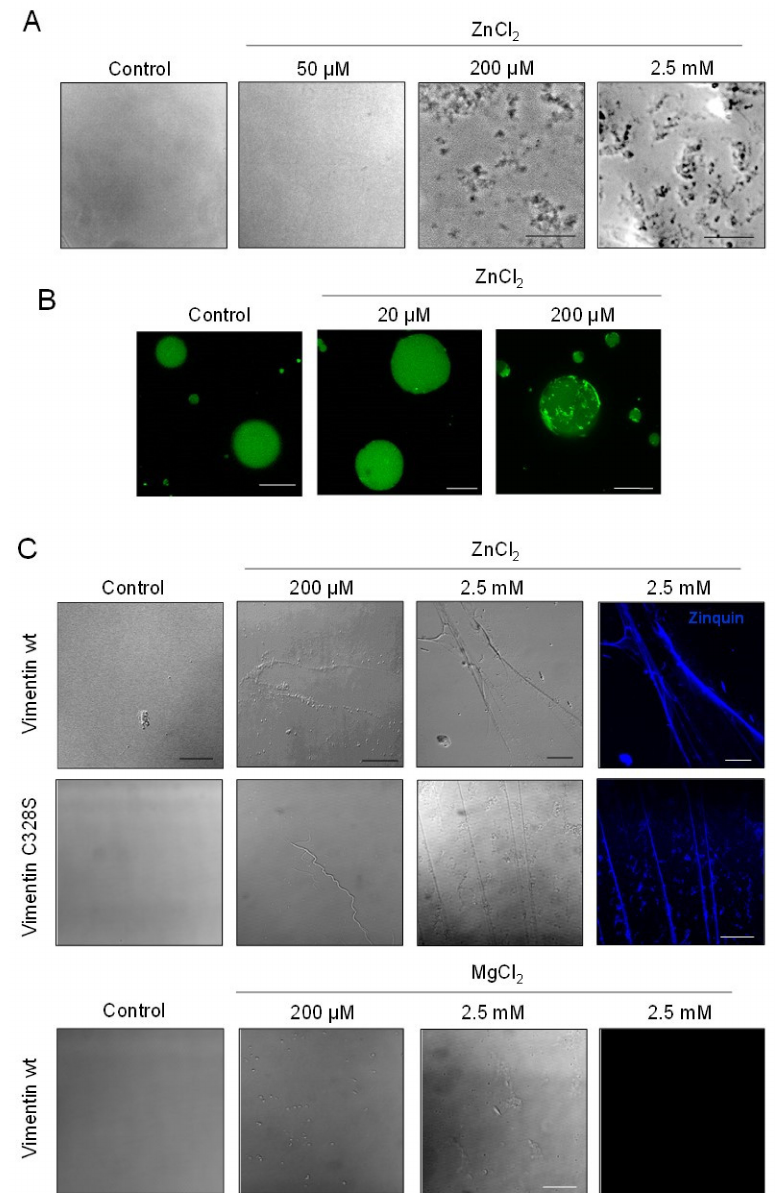
Figure 4. Observation of zinc-induced vimentin structures by optical microscopy. ( A ) Vimentin wt in 5 mM PIPES-Na pH 7.0, 0.2 mM DTT, was incubated with the indicated concentrations of ZnCl 2 in a plastic microwell plate. Mixtures were observed after 20 min incubation at r.t. Images are representative of three assays. Scale bar, 20 µ m. ( B ) Vimentin mixtures containing unlabeled and Alexa 488-labeled vimentin (4 and 1 µ M, respectively) were encapsulated in microdroplets in the presence of the indicated concentrations of ZnCl 2 , at r.t., and observed by confocal fluorescence microscopy. Overlay projections, representative of three assays, are shown. ( C ) Vimentin wt or C328S at 5 µ M in hypotonic bu ff er (5 mM PIPES-Na pH 7.0, 0.2 mM DTT) was deposited on a glass coverslip, and the control image was obtained immediately thereafter. Subsequently, ZnCl 2 or MgCl 2 was added at the indicated final concentrations, and bright field images were obtained within 10 min of addition at r.t. Finally, zinquin was added at 0.6 mM, final concentration, and structures were visualized by UV detection. Results shown are representative of at least three independent assays with similar results. Scale bars, 20 µ